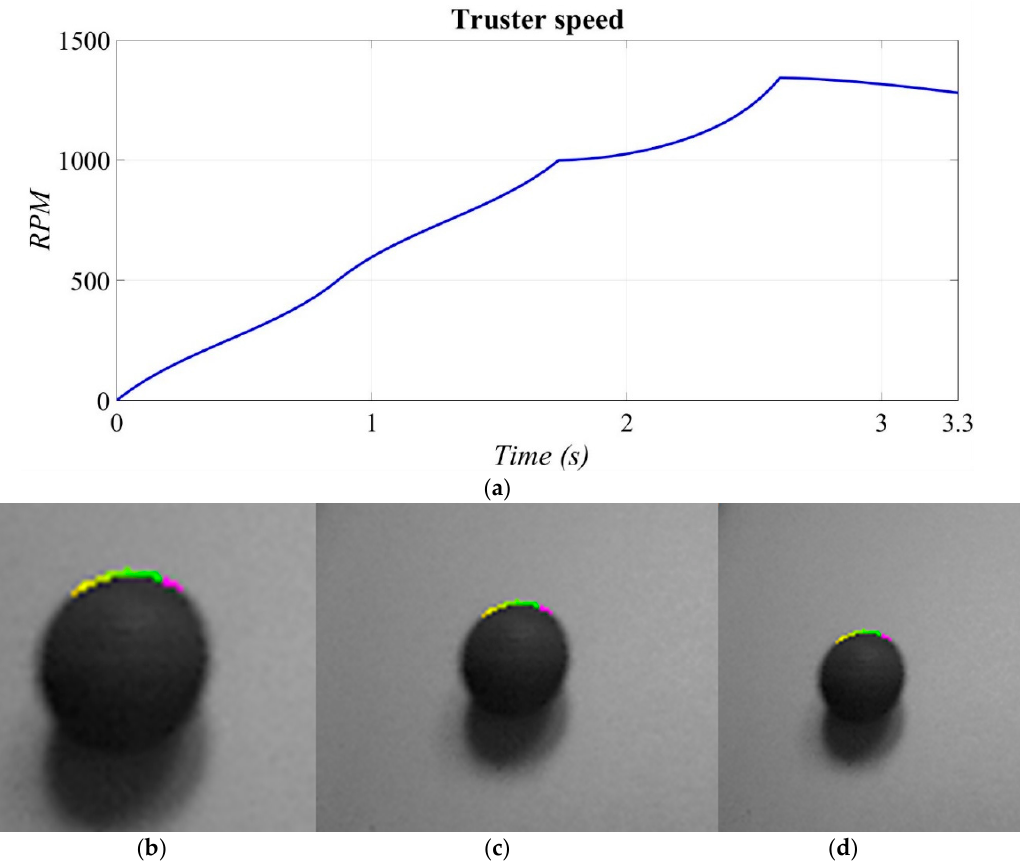
Figure 34. Diagrams of ( a ) output revolution speeds of propeller (rpm); and the corresponding three states: ( b ) AUV starts moving away from the object at state 1, ( c ) AUV continues to stay away from the object at state 2; and ( d ) AUV maintains a certain distance from the object and gradually reduce speed to avoid directly reaching 1500 rpm at state 3 by means of the optical flow method.